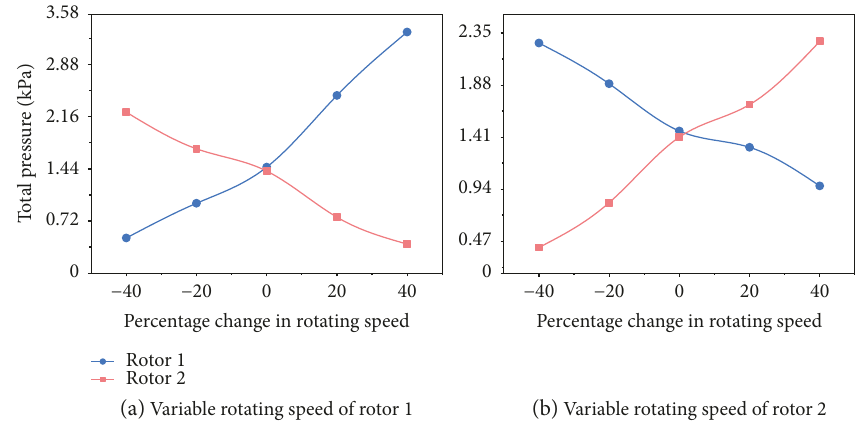
Figure 10: Total pressure characteristic lines of two-stage rotors under variable rotating